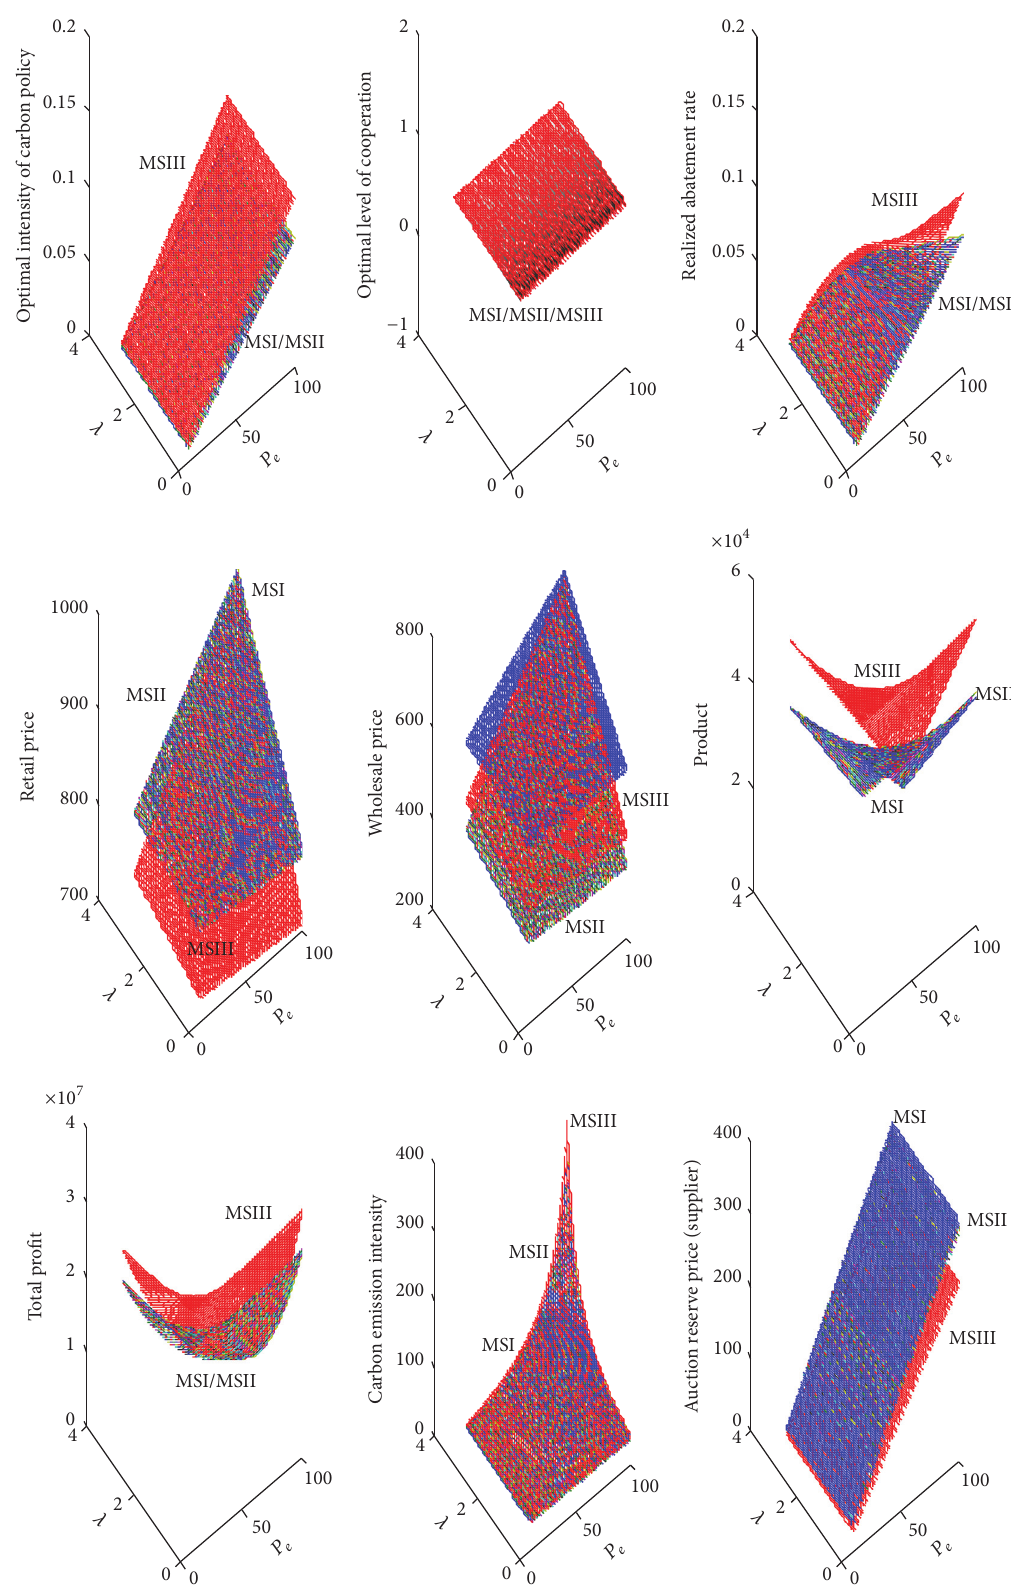
Figure 1: Changes of optimal solutions in the three modes with mixed